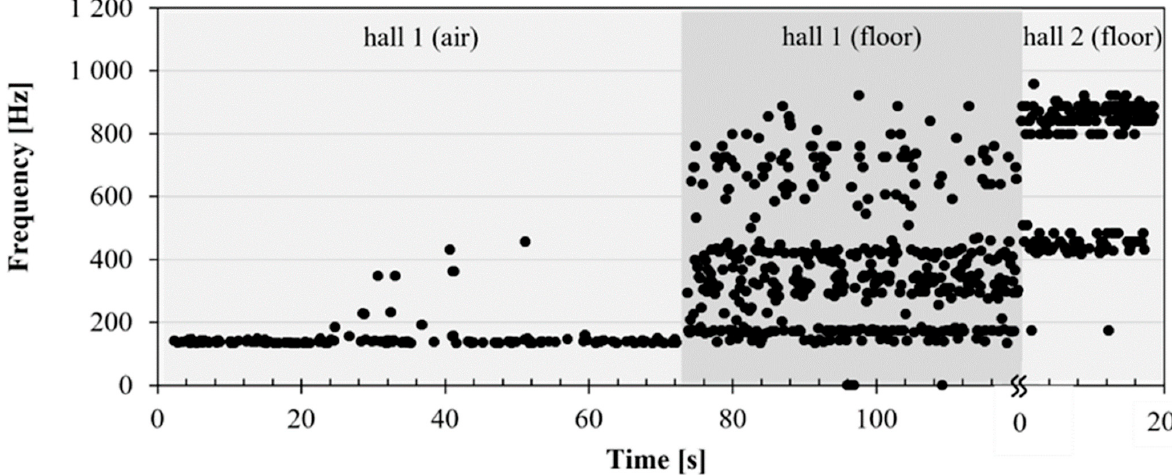
Figure A7. Frequency measurement in test hall 1 and test hall 2 outside module operation using Phyfox [58].